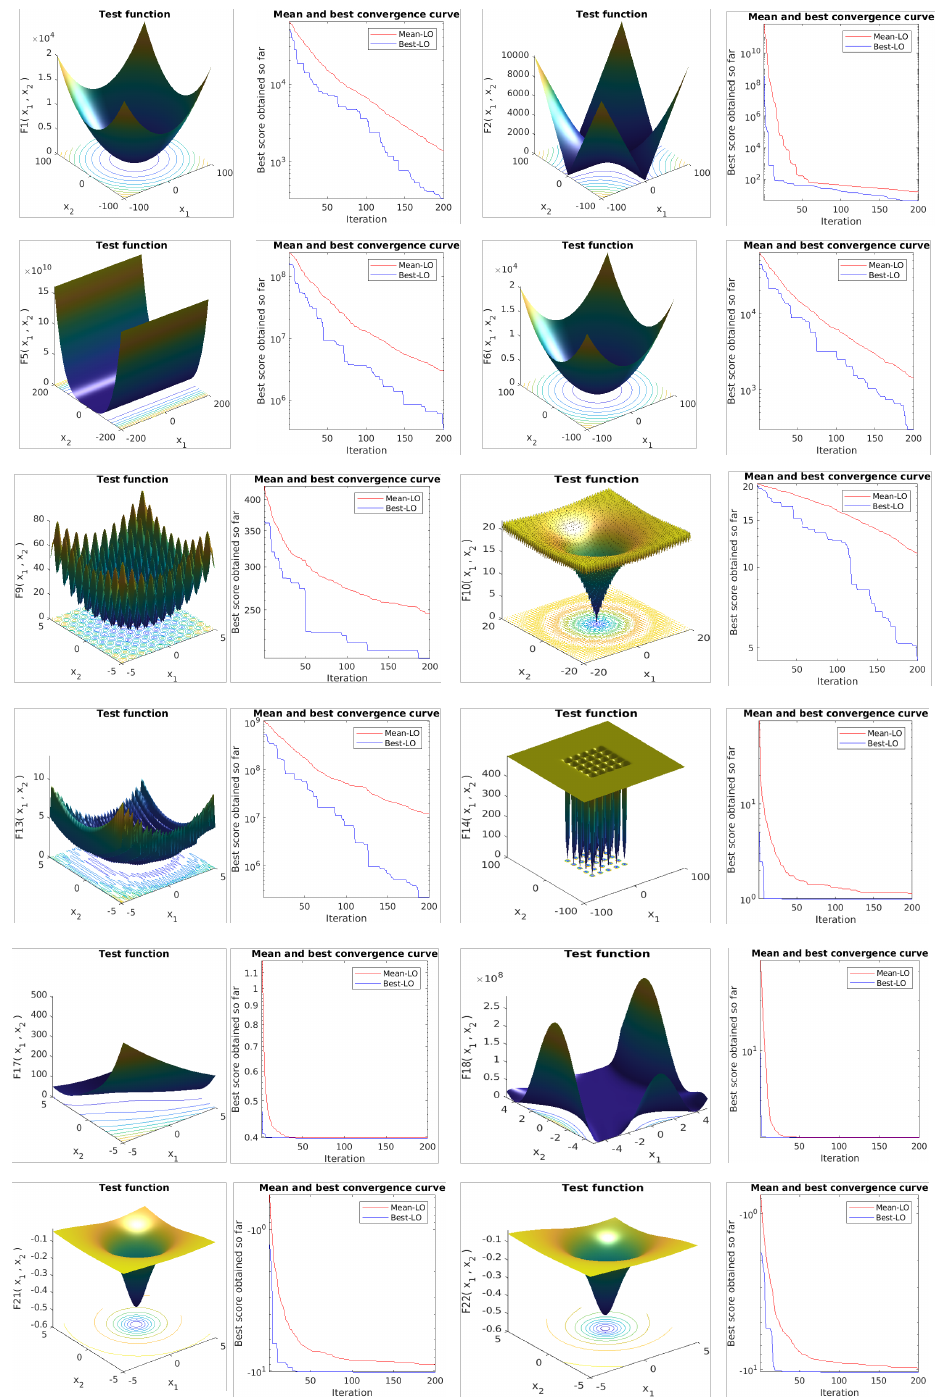
Figure 8. Functions and convergence